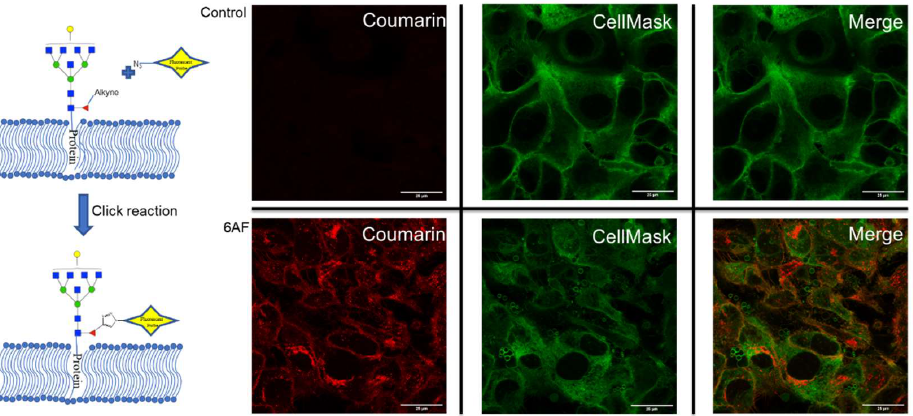
Figure 3. Confocal microscopy of PNT2 cells were the top cells without 6AF treatment (control) and the bottom cells with 6AF treatment. Cells were stained with CellMask™ (green) and 7-Azido-4- Methylcoumarin (red) (ThermoFisher, Waltham, MA, USA). The merge section is the overlap between CellMask™ and